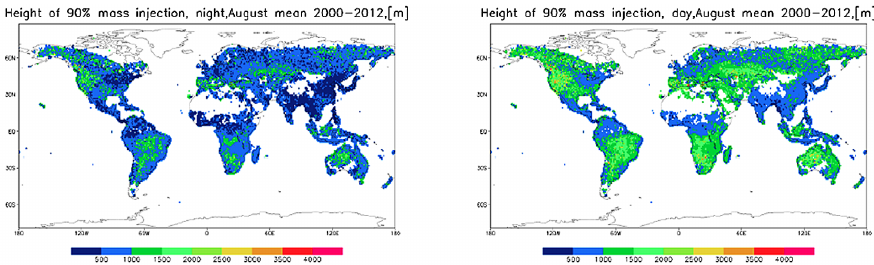
Figure 19. Injection height (in m) for 90% of the mass injection for night (left) and day (right) for August from biomass burning (Sofiev et al., 2013).